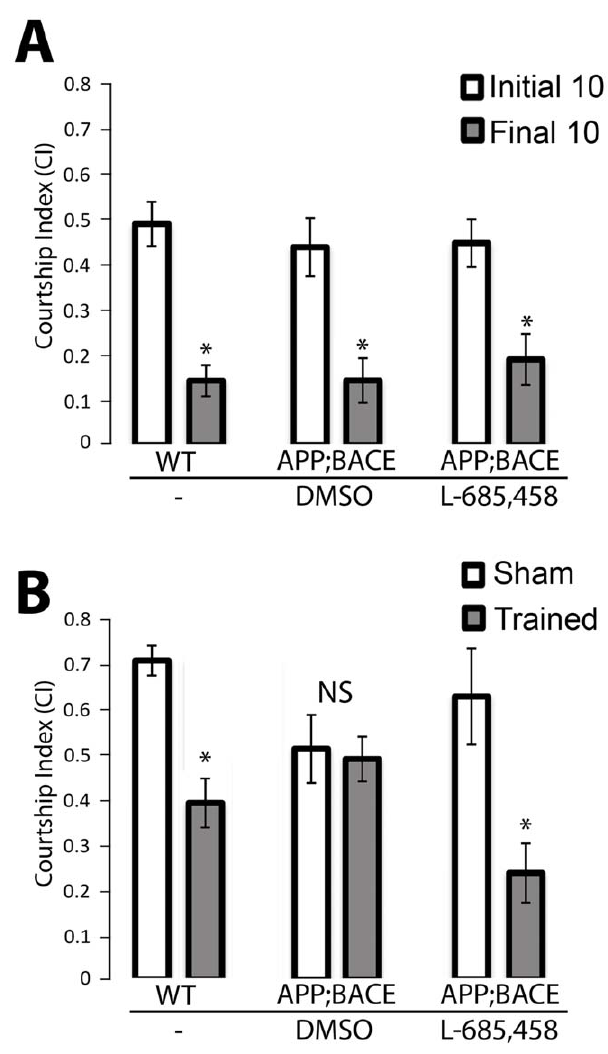
Figure 6. Learning and memory behavior. A ) Panel denotes learning ability during the first 10 minutes (white columns) and last 10 minutes (grey columns) of the courtship suppression assay training phase. Treatments are indicated and WT indicates Canton S. Note normal learning response of elav ; APP ; BACE heterozygous flies raised on either DMSO or L-685, 458. B ) Panel denotes immediate recall memory (0–2 minutes post-training) of trained flies (white columns) as compared to sham trained flies of matching genotypes and age (grey columns). elav ; APP ; BACE heterozygous flies treated with DMSO (vehicle) show no significant difference between trained and sham trained flies, indicating no immediate recall memory of training. This memory defect was rescued by treating flies with c -secretase inhibitor, L-685,458. Error bars represent standard error. * indicates p , 0.05 . n $ 18 for panels A and